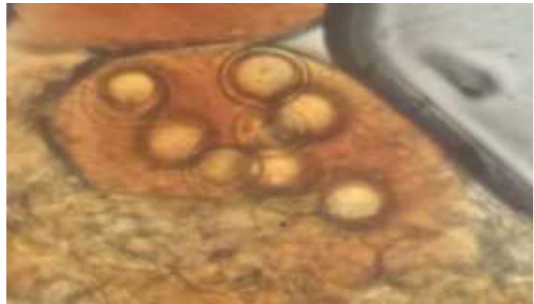
Figure 4.An ascus of Tirmania pinoyi which contains 8 smooth globose spores (colored with alcoholic iodine, magnification ×40). The results of detection about phytochemical components for dried T.claveryi and T.pinoyi indicate the probability of containing alkaloids, coumarins, flavonoids, phenols, and steroid and triterpenoid glycosides. T.claveryi also may contain little of saponins (Table 1). This is the first time that determination of chemical composition to truffle was published.